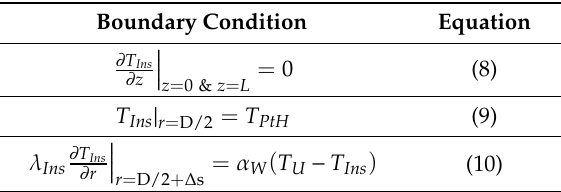
Table 1. Boundary conditions for the reference concept.